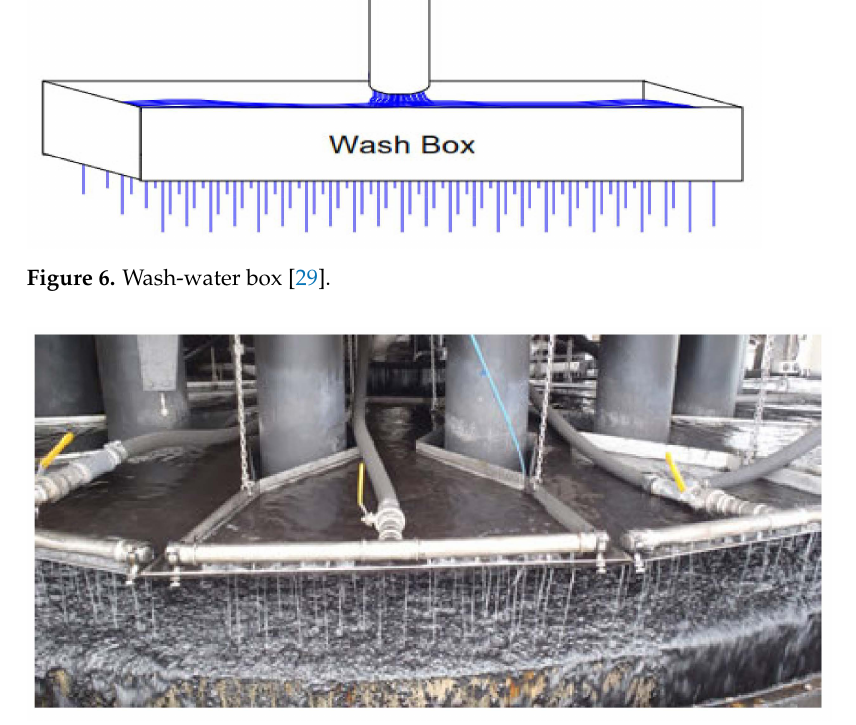
Figure 7. Wash-water trays